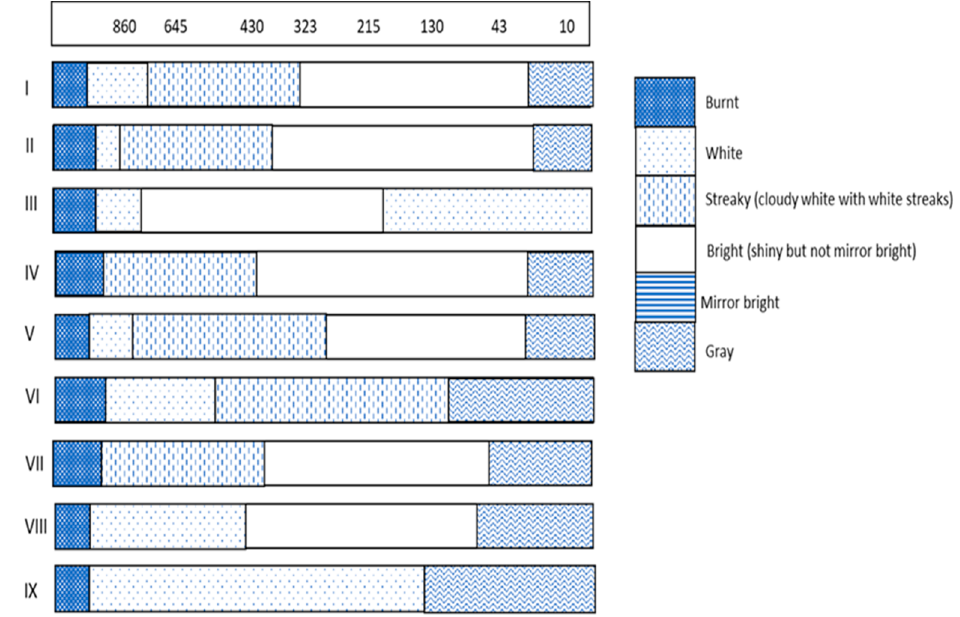
Figure 2. Hull cell deposit appearances produced by plating baths with various additive concentra- tions (see Table 1). Bath composition was 37.5 g L − 1 zinc and 210 g L − 1 NaOH held at 40 °C. A Hull cell ruler is presented at the top with current densities in A m − 2 .